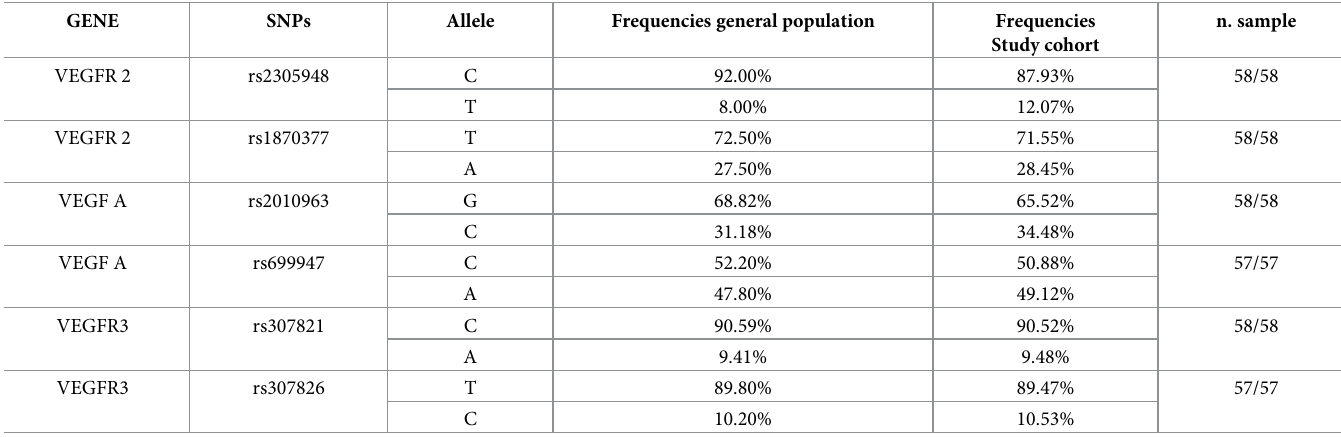
Table 4. Genotype and allele frequencies of evaluated